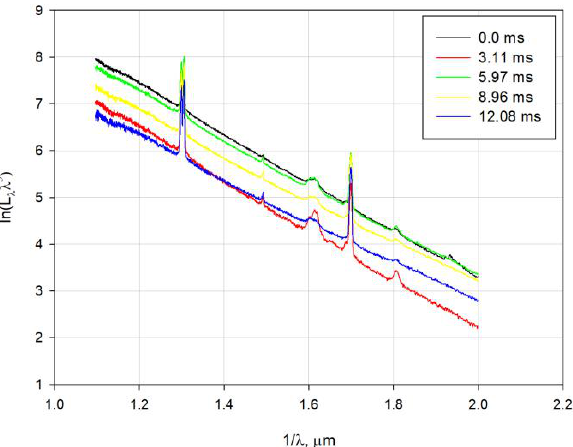
(cid:0) (cid:1) L λ λ 5 in the function of 1/ λ for the A3-25